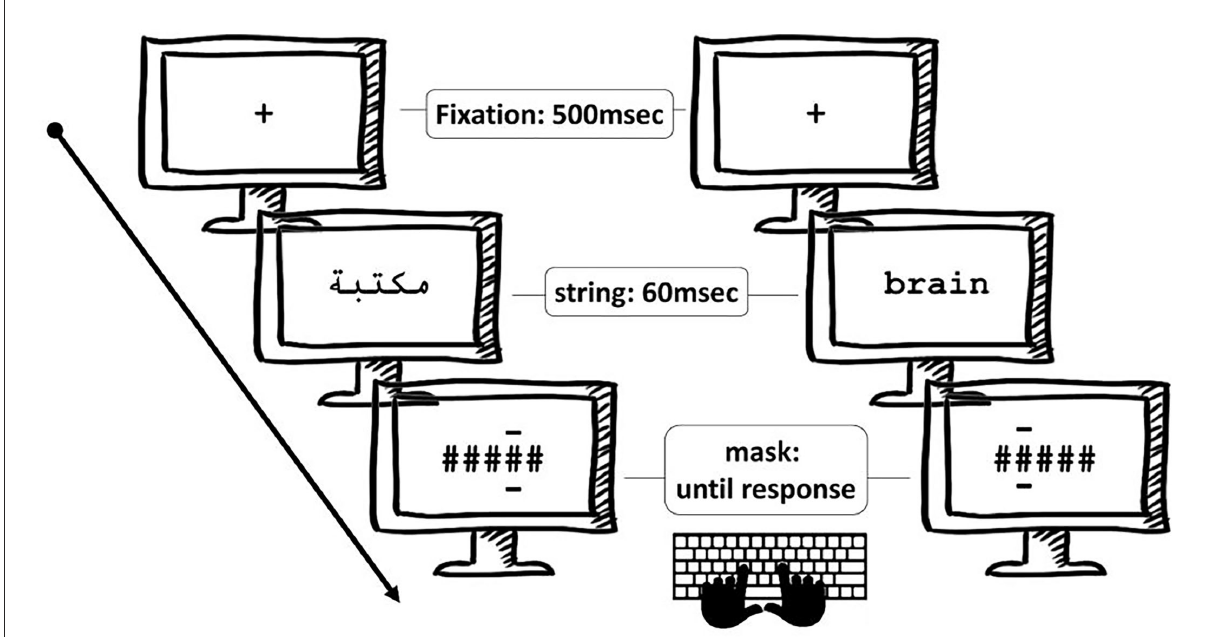
FIGURE3 Illustration of the experimental procedure for the post-cued letter-in-string identification task with Arabic stimuli (left panel) and English stimuli (right panel). Letters in position 2 for both languages were post-cued in these two examples of trial.